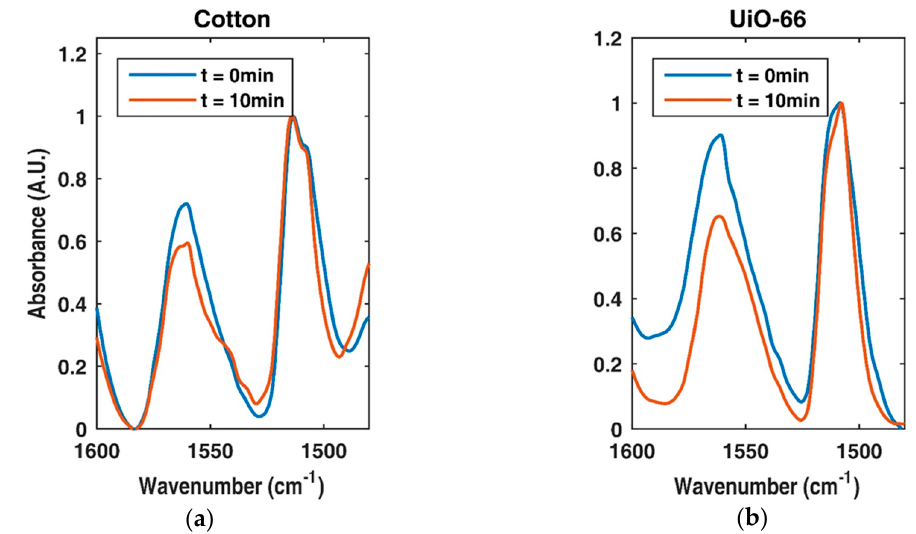
Figure 8. Acetaminophen adsorbed on ( a ) bare cotton fabric and ( b ) cotton fabrics functionalized with UiO-66. The Fourier transform infrared spectroscopy (FTIR) spectra in blue represents time zero and the spectra after 10 min of exposure to UV is shown in red.